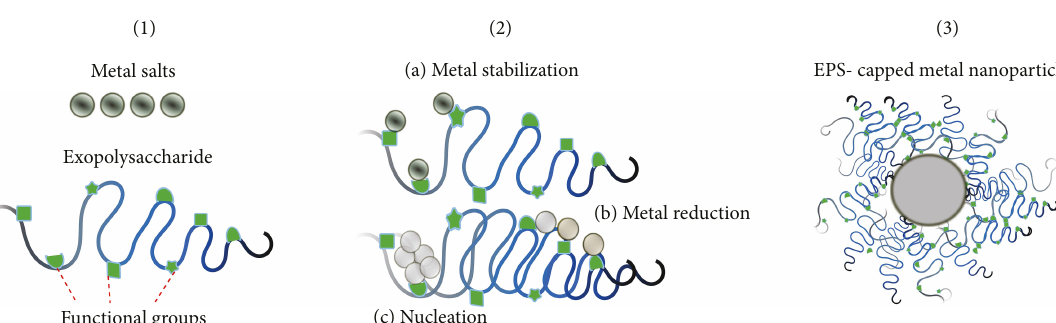
Figure 3: Proposed mechanism during synthesis of metal nanoparticles by EPSs. Electrostatic attractive forces between functional groups of EPS and metal salts lead to stabilization and reduction of metal ions to form their respective metal nanoparticles capped by the